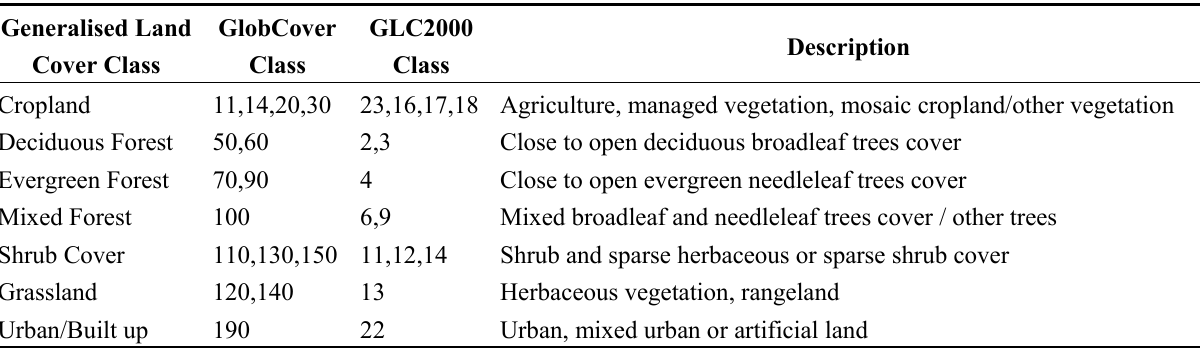
Table 1. Land Cover (LC) class codes and descriptions after aggregation of GlobCover and GLC2000 products. Water was not classified but taken from a water mask made for the Moderate-resolution Imaging Spectroradiometer (MODIS) satellite sensor